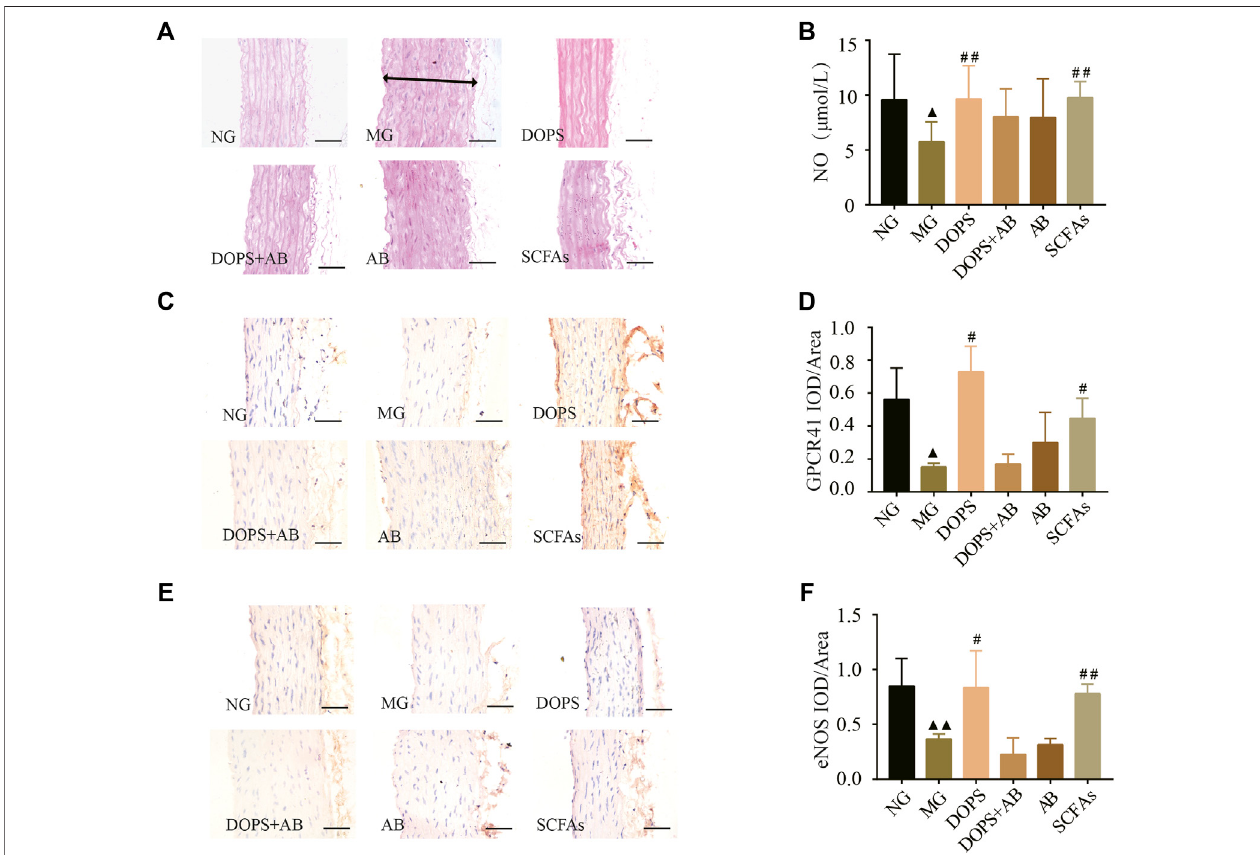
FIGURE 6 | Effect of DOPS on aorta GPCR41-eNOS in the MH rats. (A) Representative graphs of H&E staining in the aorta (× 400). The two-way arrows indicate the thickness of the aortic arch in the model group. (B) The content of nitric oxide (NO) in serum. (C) Representative graphs of G protein-coupled receptor 41 (GPCR41) immunohistochemical staining in the aorta (×400). (D) Data statistics of the expression of GPCR41 in aorta. (E) Representative images of aorta endothelial nitric oxide synthase (eNOS) immunohistochemical staining (×400). Bar = 50 μ m. (F) Data statistics of the expression of eNOS in aorta. NG, normal control group; MG, model control group; DOPS, Dendrobium of fi cinale polysaccharide; DOPS + AB, Dendrobium of fi cinale polysaccharide + antibiotics; AB, antibiotics; SCFAs, short-chain fatty acids. Compared with the normal control group, ▲ p < 0.05 and ▲▲ p < 0.01; compared with the model control group, # p < 0.05 and ## p < 0.01.